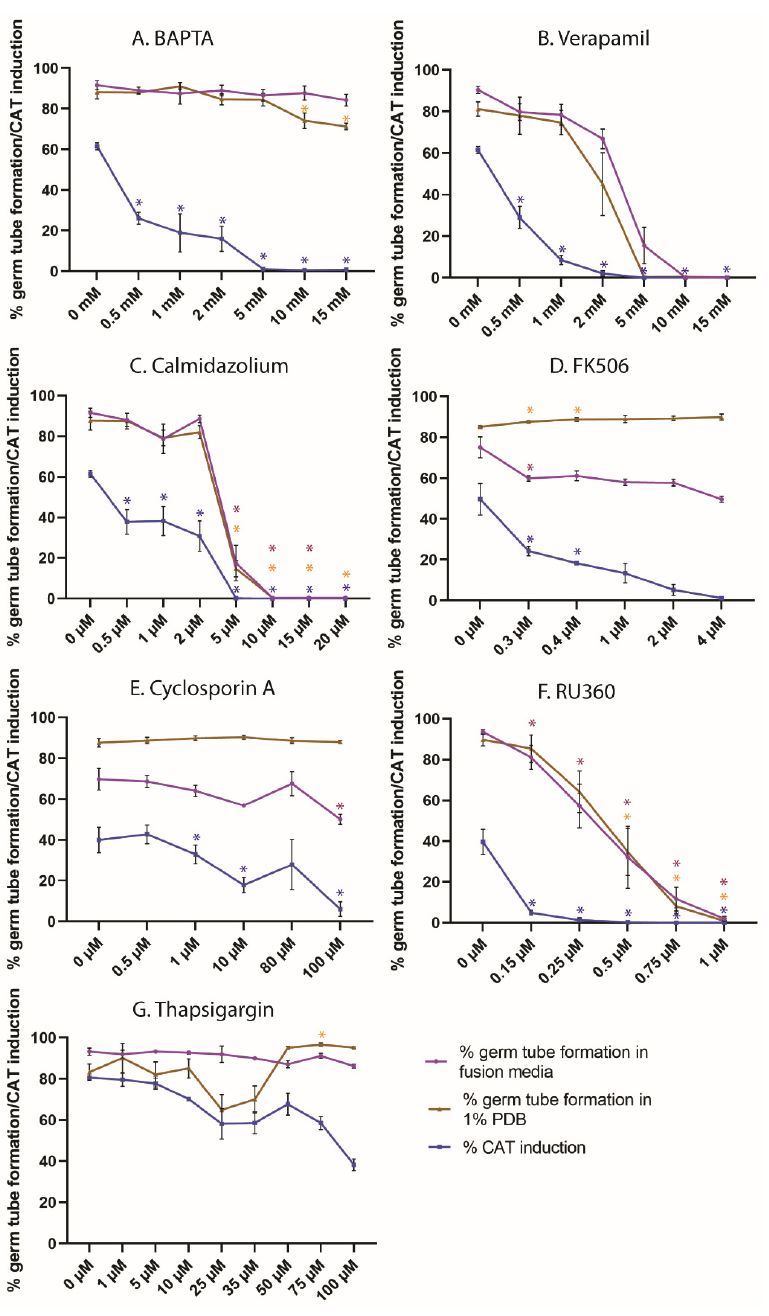
Figure 2. Effect of calcium-signalling inhibitors on germination and CAT-mediated cell